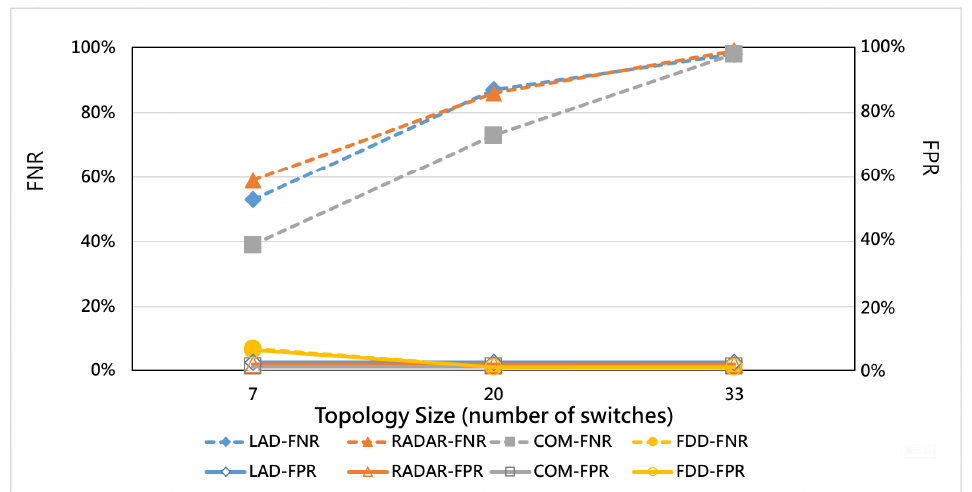
Figure 10. FNR and FPR vs. number of switches.